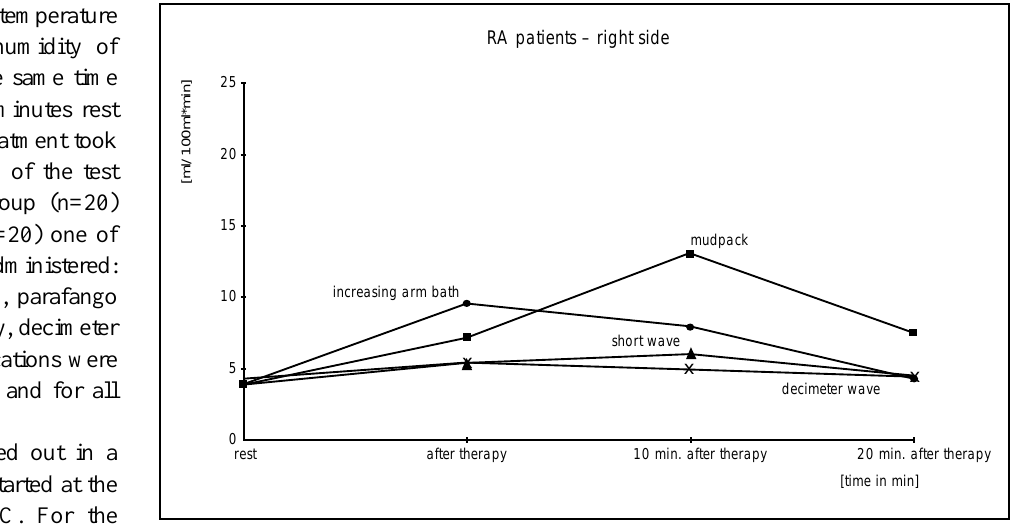
Figure 1: Forearm blood flow after application of the different methods of thermo- therapy in the patient groups (n = 20).